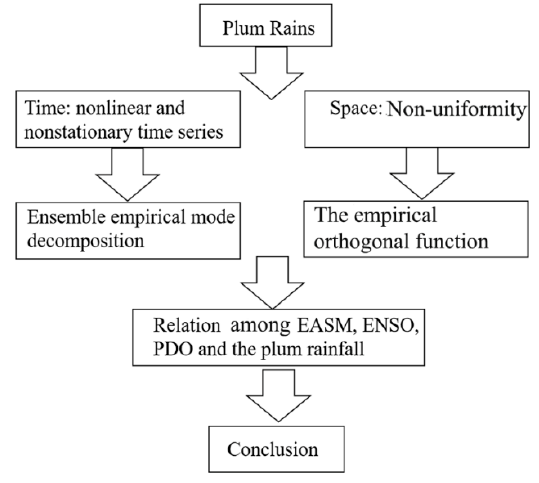
Figure 2. The framework of this study.